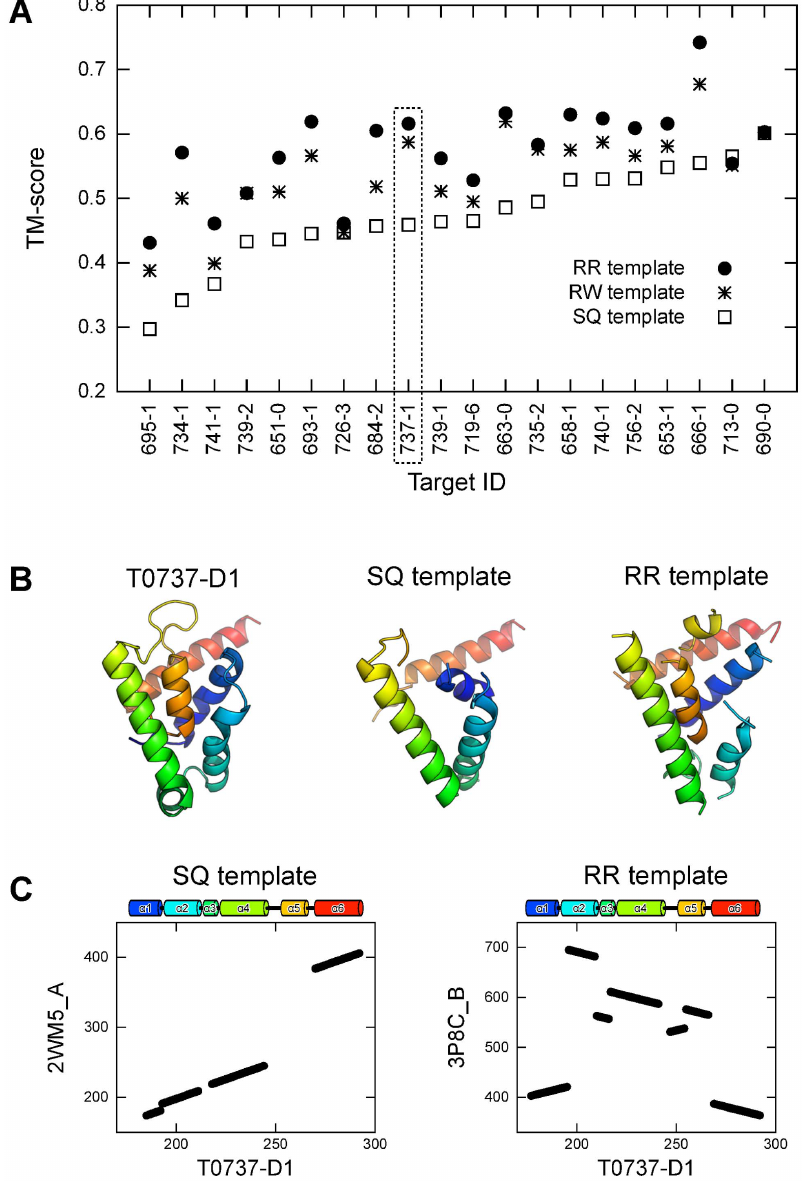
Figure 11. SQ, RW, and RR templates for FM targets in CASP10. (A) TM-scores of the SQ, RW, and RR templates identified from the PDB snapshot for all FM targets in CASP10. The target domains are ordered according to the TM-scores of their SQ templates. Open squares, asterisks, and filled circles represent TM-scores of SQ, RW, and RR templates, respectively. (B) The native (3td7), the SQ template (PDB id: 2wm5), and the RW template (3p8c) structure of the target T0737-1. For the template structures, only the aligned residues are shown as cartoon models. (C) The alignment plots between the native and the SQ template (left) and between the native and the RR template (right). doi:10.1371/journal.pone.0107959.g011 within (0,1 (cid:2) . Statistical analysis revealed that a TM-score v 0 : 17 corresponds to a random similarity, whereas a TM-score § 0 : 5 implies that the structures share the same topology [32]. Note that the TM-score is non-symmetric for protein pairs with different lengths: TM-score( A ? B ) = TM-score( B ? A ). For a given where N A is the length of the target protein A , N ali is the number protein pair A and B , we calculated the TM-score X (A ? B), of aligned residues, d i is the distance between the C a atom of the where TM-score X is the TM-score calculated with the X ( [ SQ, i -th pair of aligned residues and d 0 is a scale to normalize the RW, RR) scheme, using a program MICAN [26]. p { 1 : 8 . This match difference defined as d 0 ~ 1 : 24 | ffiffiffiffiffiffiffiffiffiffiffiffiffiffiffiffi N A { 15 3 Theoretically, it necessarily holds that TM-score RR (A ? B) § formula was introduced to eliminate the inherent protein size TM-score RW (A ? B) § TM-score SQ (A ? B) because the RR dependence of the score function. The value of the TM-score lies (RW) scheme allows a larger alignment search space than the RW